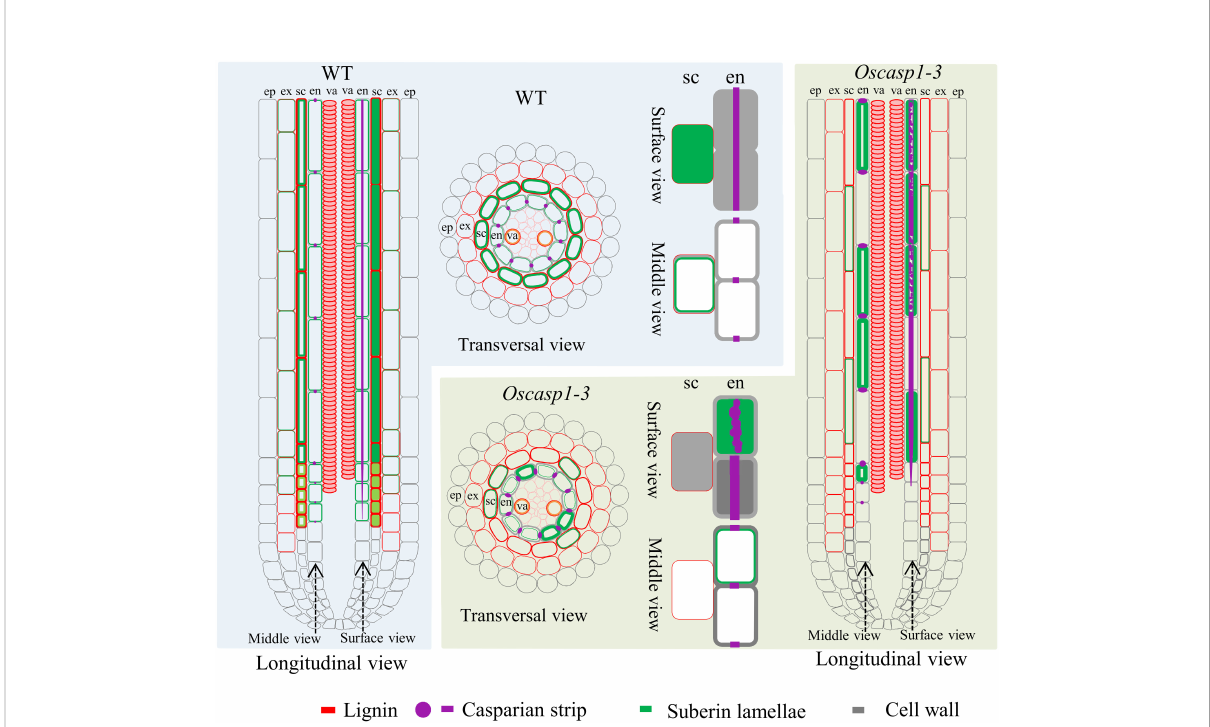
FIGURE 8 Schematic longitudinal and transversal views of SLRs and single cells showing characteristics of SLRs and the differences between WT and Oscasp1-3 in rice. Lignin and suberin depositions in the endodermis and sclerenchyma are represented by red and green lines, respectively. CSs are represented by purple dots and lines, and cell walls are represented by grey lines. ep, epidermis; ex, exodermis; sc, sclerenchyma; en, endodermis; va, vascular